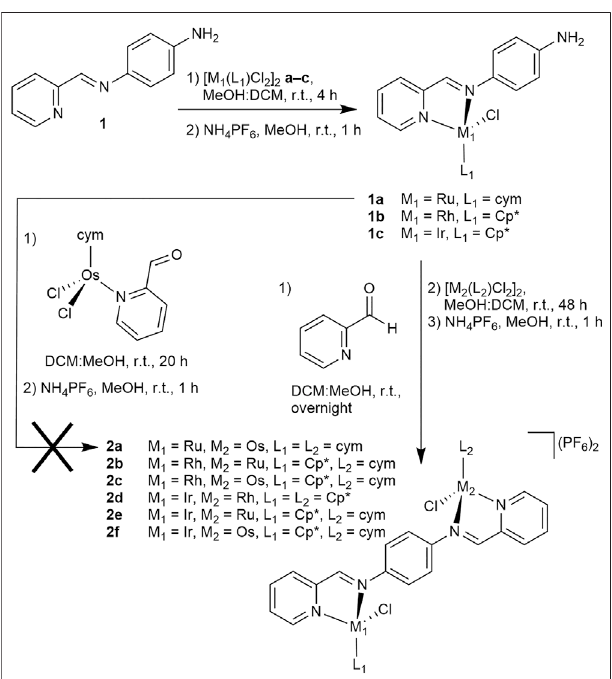
SCHEME 1 | Synthetic strategy towards heterodimetallic complexes 2a – 2f